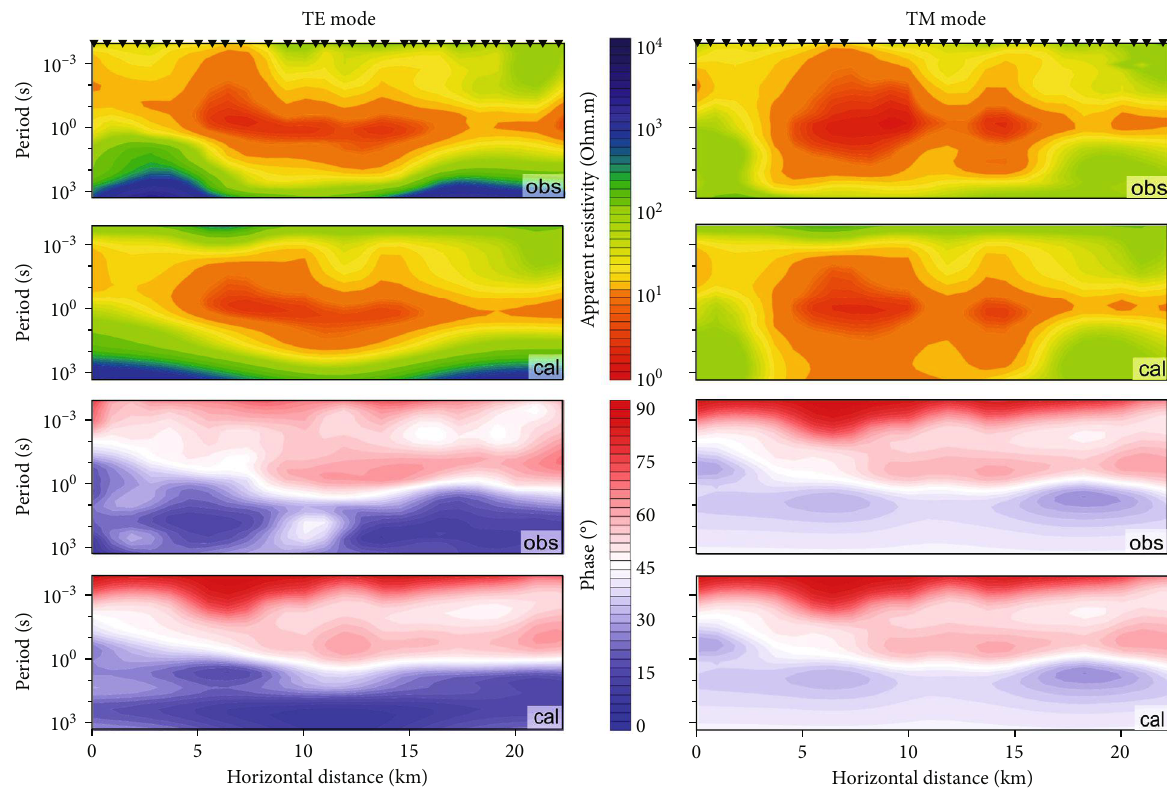
Figure 11: Apparent resistivity and phase pseudosection of MT model for line E-E ′ (southernmost line); observed (obs) and calculated